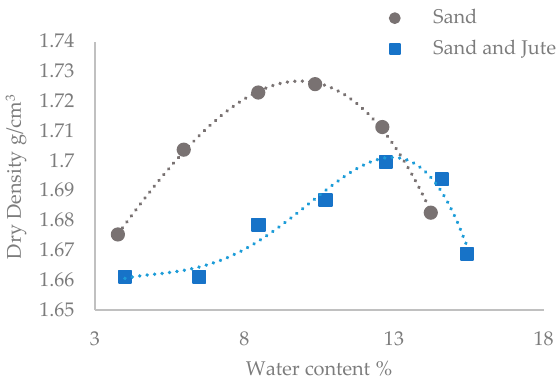
Figure 4. Proctor compaction curves for sand only and fibre and sand mixtures. Figure 5. Proctor compaction curves for sand only and fibre and sand mixtures.